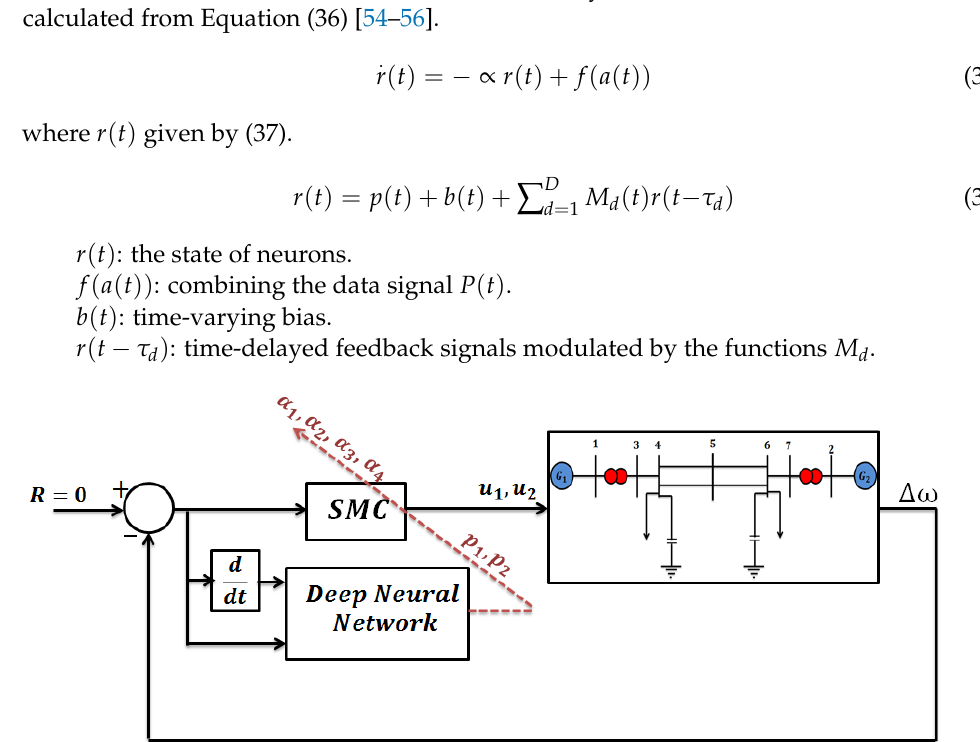
Figure 5. Deep neural network structure.